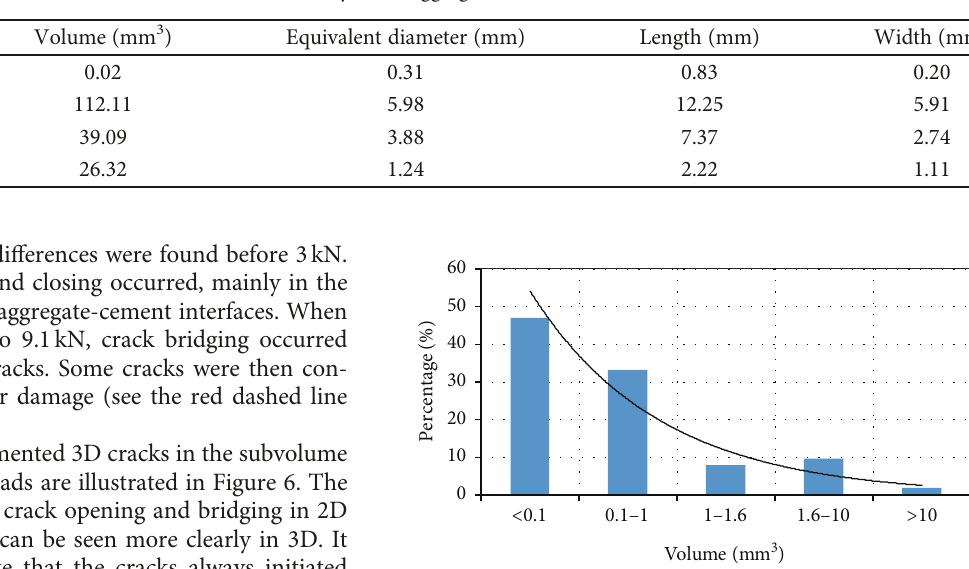
Figure 9: Volume distribution of aggregates. Table 3: Statistical analysis for aggregates in the cube.